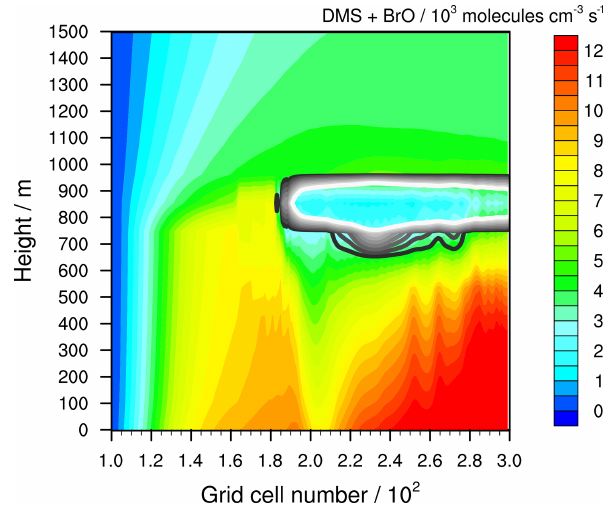
Figure 9. Simulated oxidation rate of DMS by BrO in the stable me- teorological condition simulation with stratiform clouds after 12h of modelling time. The x axis represents the innermost horizontal grid cells divided by 100. The black contour lines represent the sim- ulated clouds. The black line corresponds to a LWC of 0.01gm − 3 and the white line to 0.1gm − 3 . The area framed by the white line includes LWC above 0.1gm − 3